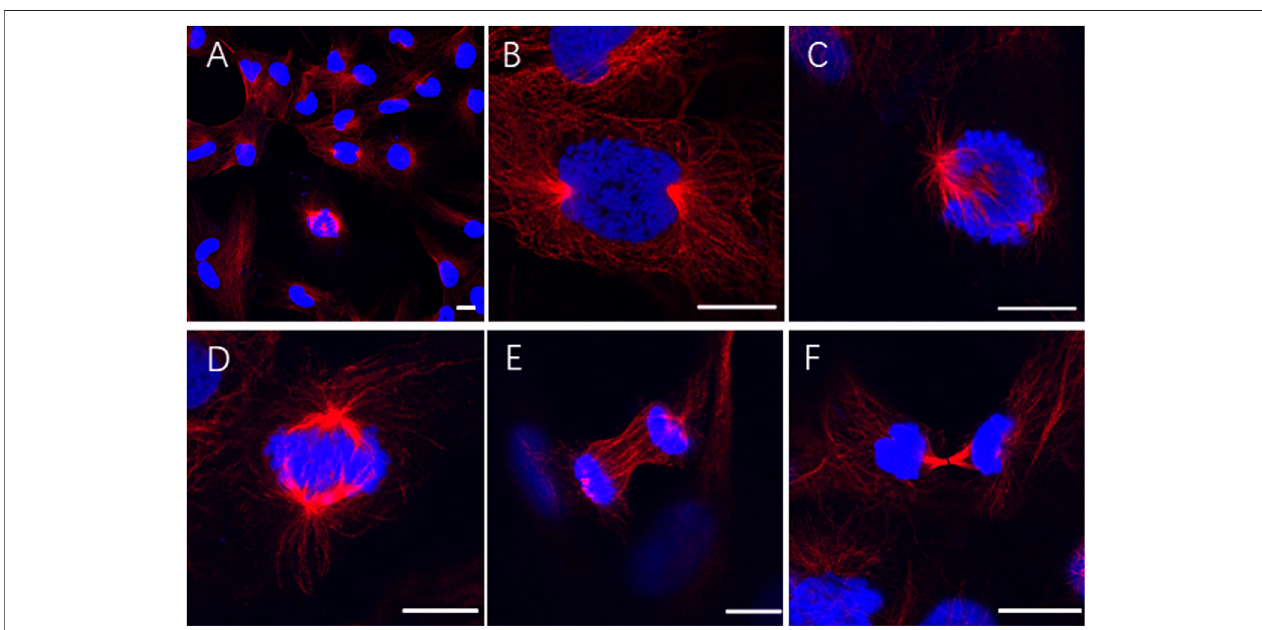
FIGURE 2 | Immuno fl uorescence observation of chromosome behaviors in the SP600125-induced tetraploid (SP4N) cells. (A) presents 21 passages of the SP4N cells. (B – F) present the SP4N cells in prophase (B) , pro-metaphase (C) , metaphase (D) , anaphase (E) and telophase (F) of the mitosis, respectively. α -Tubulin (red) was detected by immunostaining, and DNA (blue) was stained with Hoechst 33342. All the scale bars represent 10 µm. Cell migration ability and observed mitochondria in three types of